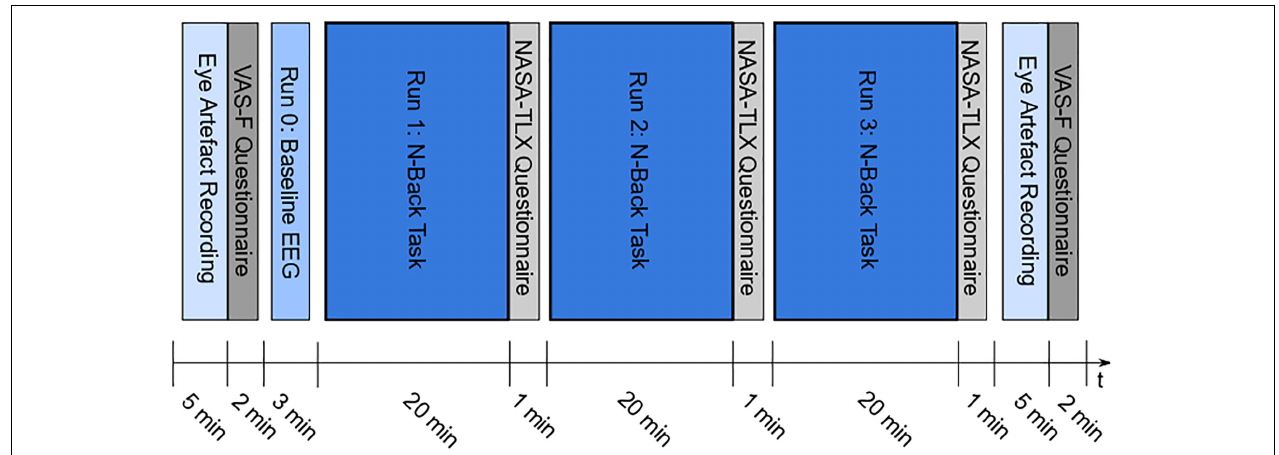
FIGURE 1 | Experimental design – Paradigm for eye artifact recording at the beginning and at the end of the experiment, followed by the VAS-F questionnaire; Run 0: passive screening of the task to record the baseline EEG; Run 1, 2, and 3: performing letter n -back task, followed by NASA-TLX questionnaire.